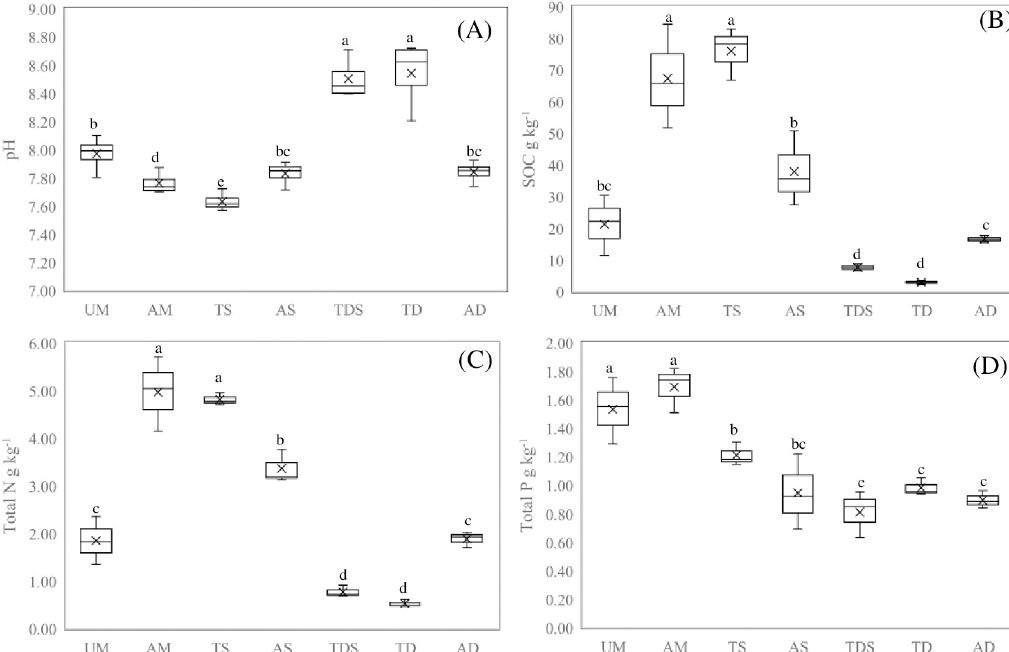
Fig 1. Content of C, N, P and pH in different types grassland. Different lower-case letters mean different type grasslands significant differences at 0.05 level. TS, Temperate steppe; AM, Alpine meadow; AS, Alpine steppe; UM, Upland meadow; AD, Alpine desert; TDS, Temperate Desert Steppe; TD, Temperate